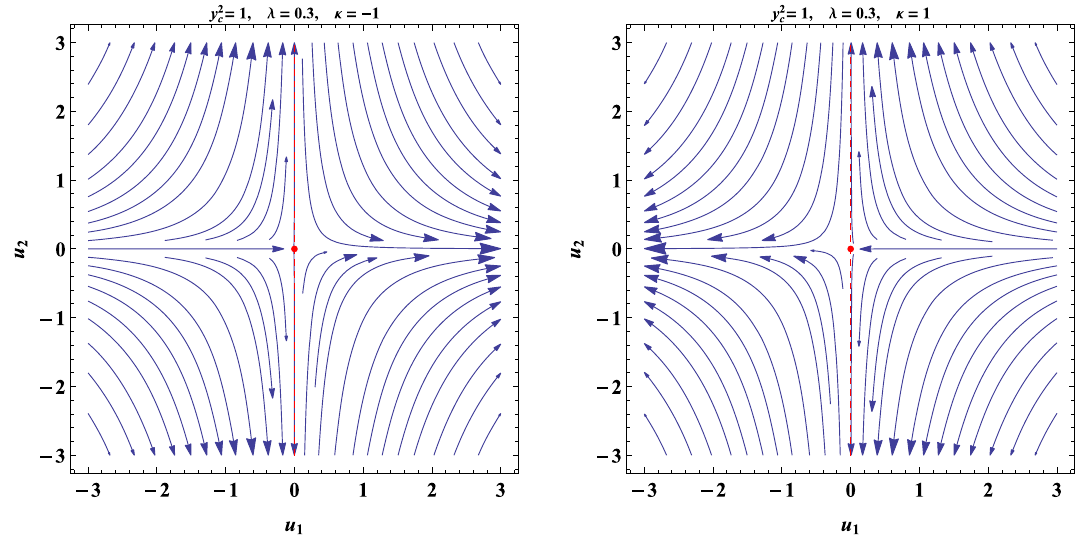
is a saddle point 2